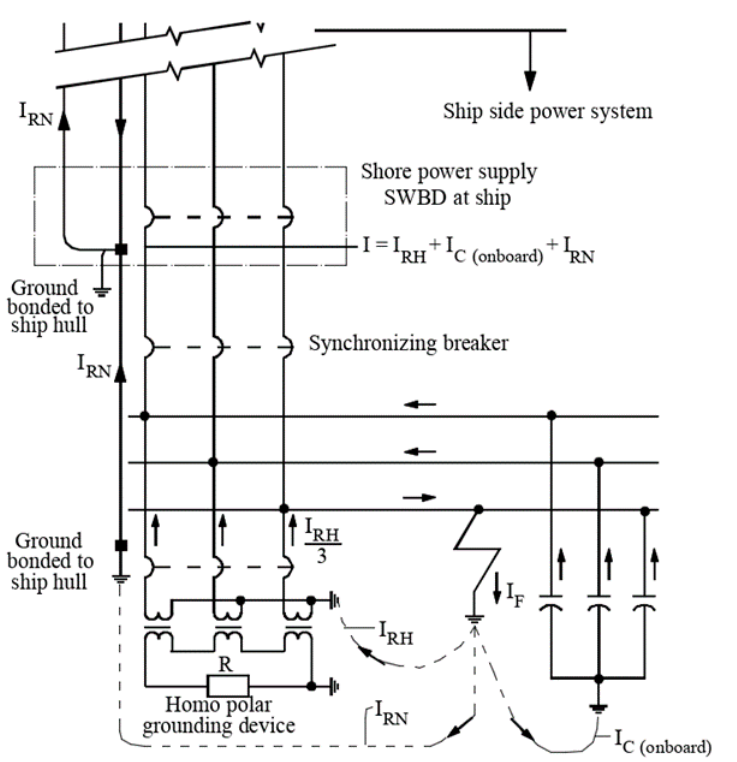
Figure 7. Current path between a ship’s electrical installation capacitances and the hull and pier [14]. Reprint with permission [4926950096338] from 2009 IEEE Proceedings; published by IEEE; Oct. 2009.